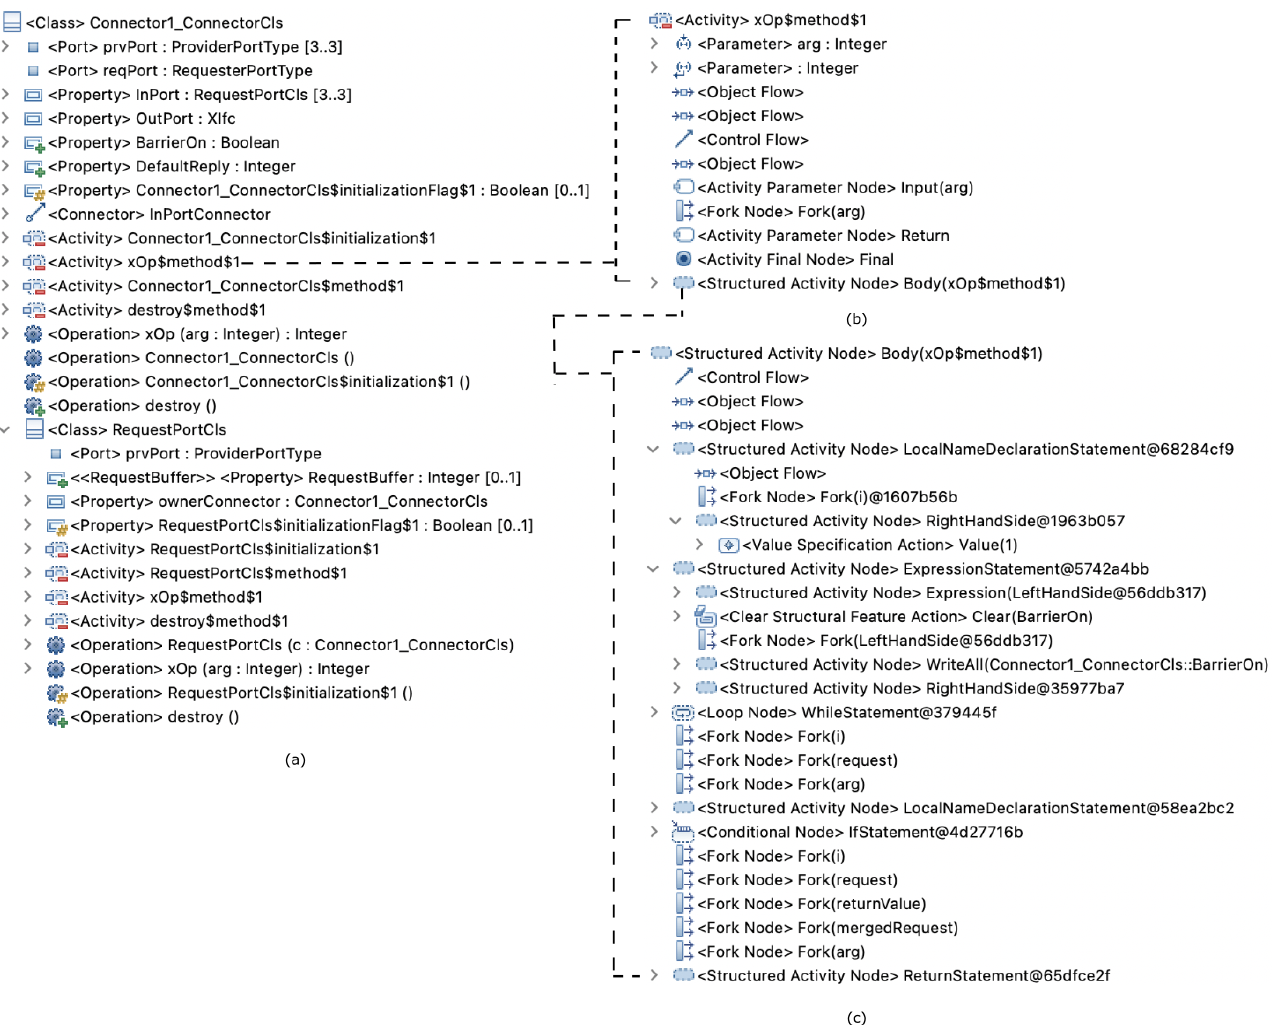
Figure 14. ( a ) E3 UML model for the request barrier connector class. ( b ) E3 UML model for the request barrier connector fUML activity. ( c ) Inner elements of the E3 model request barrier connector fUML